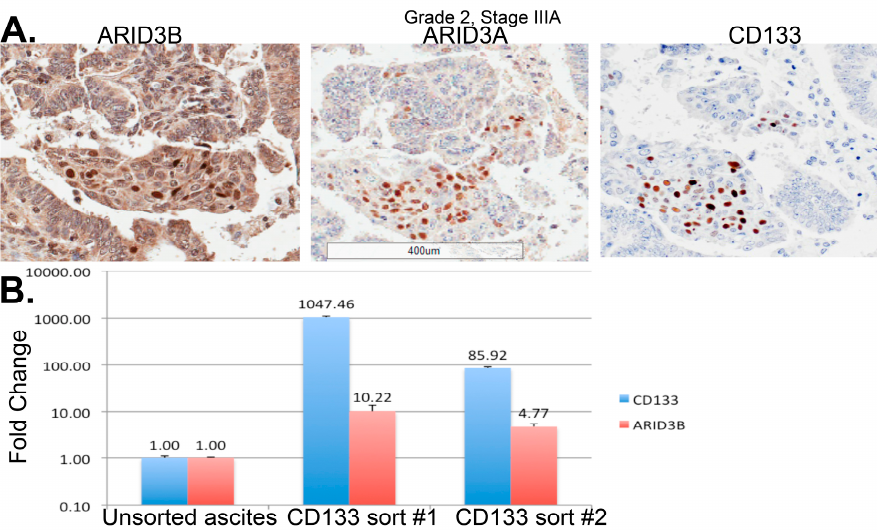
Figure 4. ARID3B expression correlates with CD133-stem cell niche. ( A ) IHC shows nuclear ARID3A and ARID3B co-localize with CD133+ regions in serial HGSOC sections. ( B ) HGSOC patient ascites was sorted for CD133+ cells. RT-qPCR was conducted for Prom1(CD133) and ARID3B on unsorted and independent sorts [98].